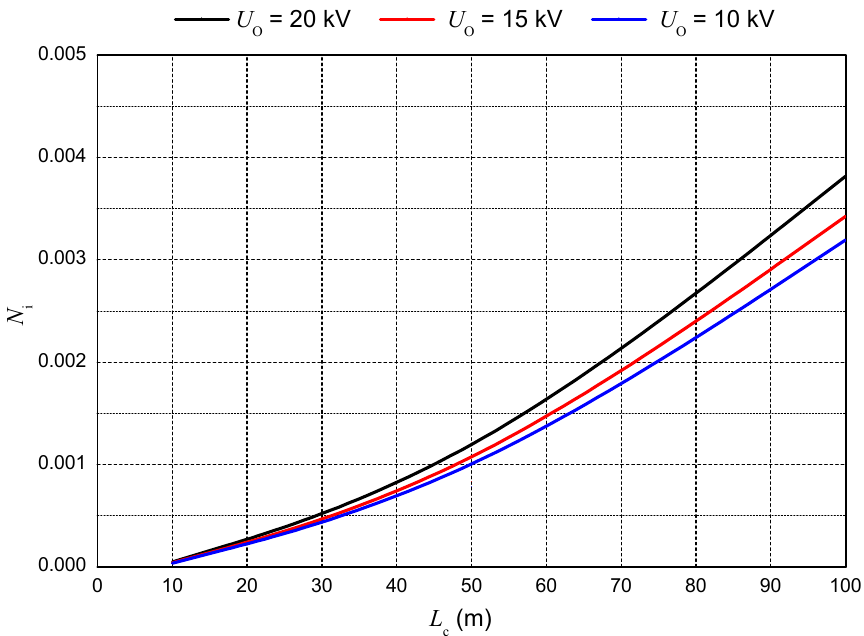
Figure 10. Frequency of damage N I to apparatus as a function of the length L c of the LV circuit in conduit.